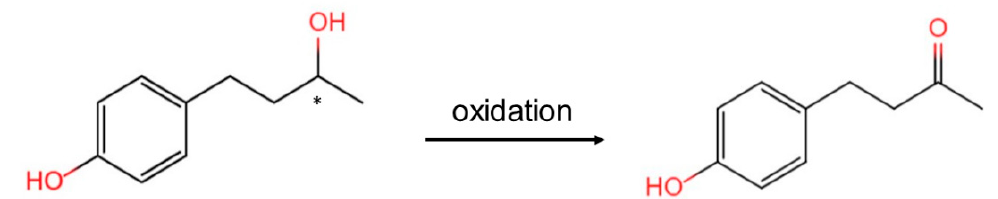
Figure 1. Oxidation of rhododendrol (RD) to raspberry ketone (RK). * : asymmetric carbon.